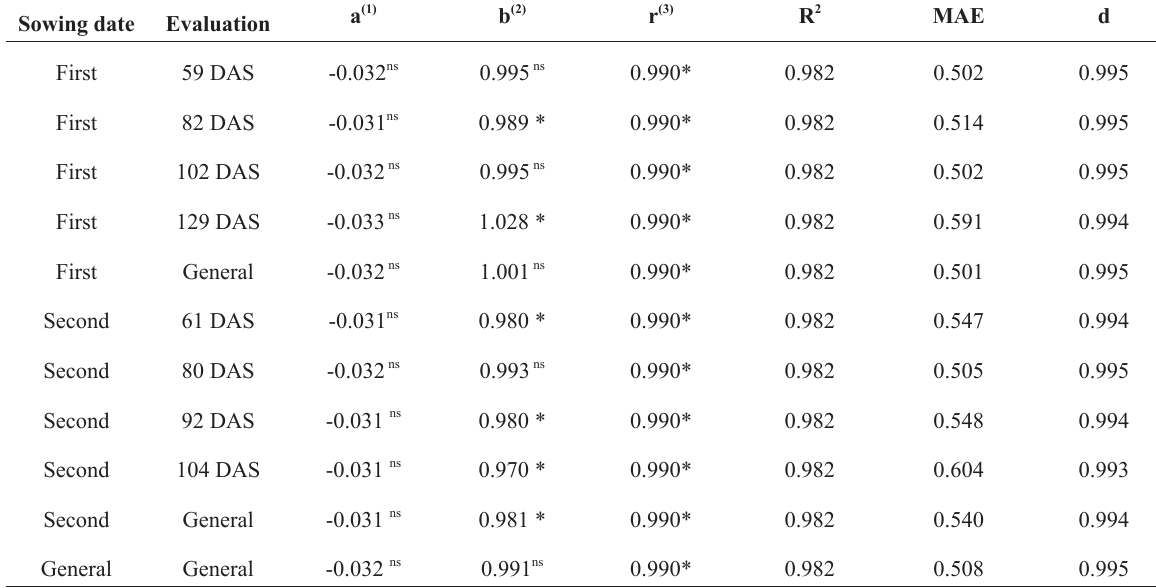
Validation of models with 800 leaves evaluated in four times by two sowing